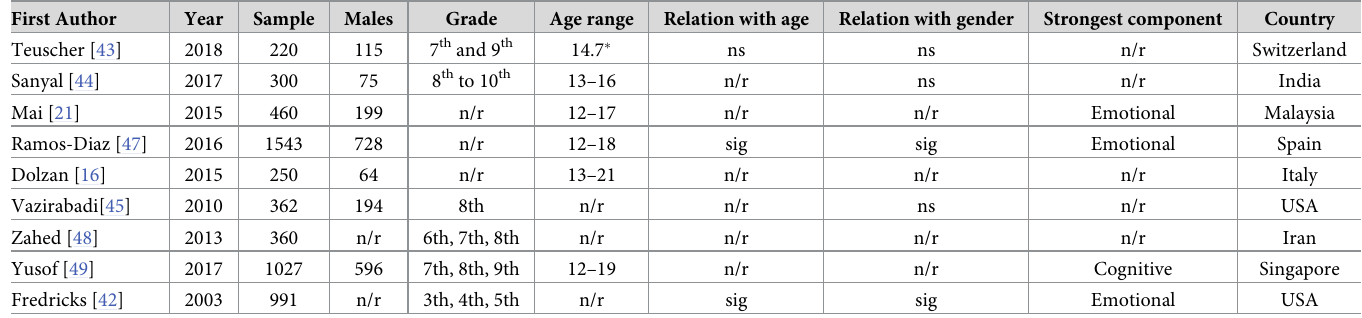
Table 1. A selected review of studies that used or adapted the school engagement scale by Fredricks et al